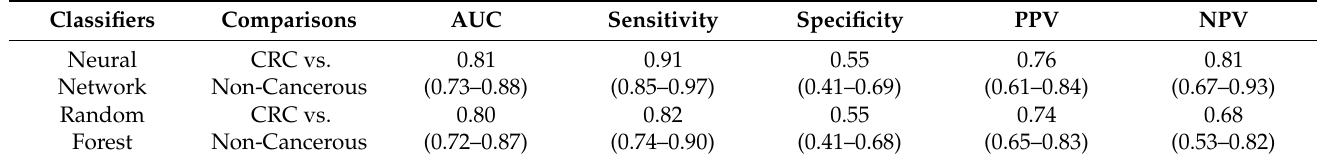
Table 3. Statistical Results for PEN3 with 95% confidence intervals in brackets.